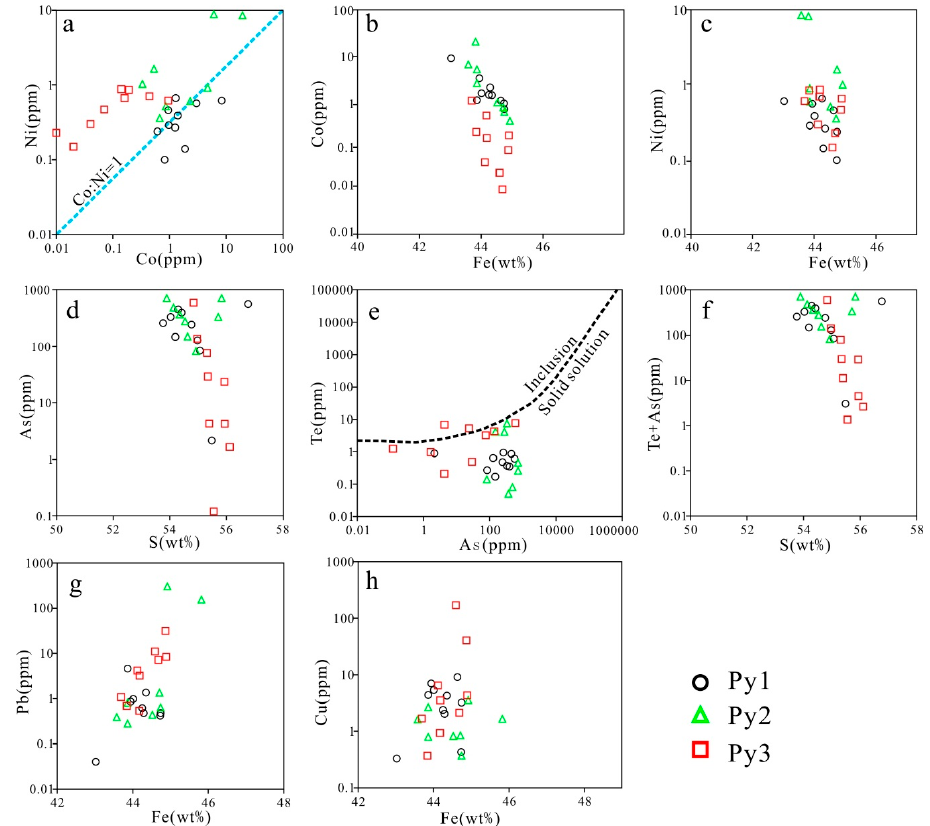
Figure 8. Binary correlation diagram of trace elements in different types of pyrite. ( a ) plot of Co vs. Ni; ( b ) plot of Fe vs. Co; ( c ) plot of Fe vs. Ni; ( d ) plot of S vs. As; ( e ) plot of As vs. Te. Solubility line on (e) modified after Keith et al. [30]; ( f ) plot of S vs. Te + As; ( g ) plot of Fe vs. Pb; ( h ) plot of Fe vs. Cu.